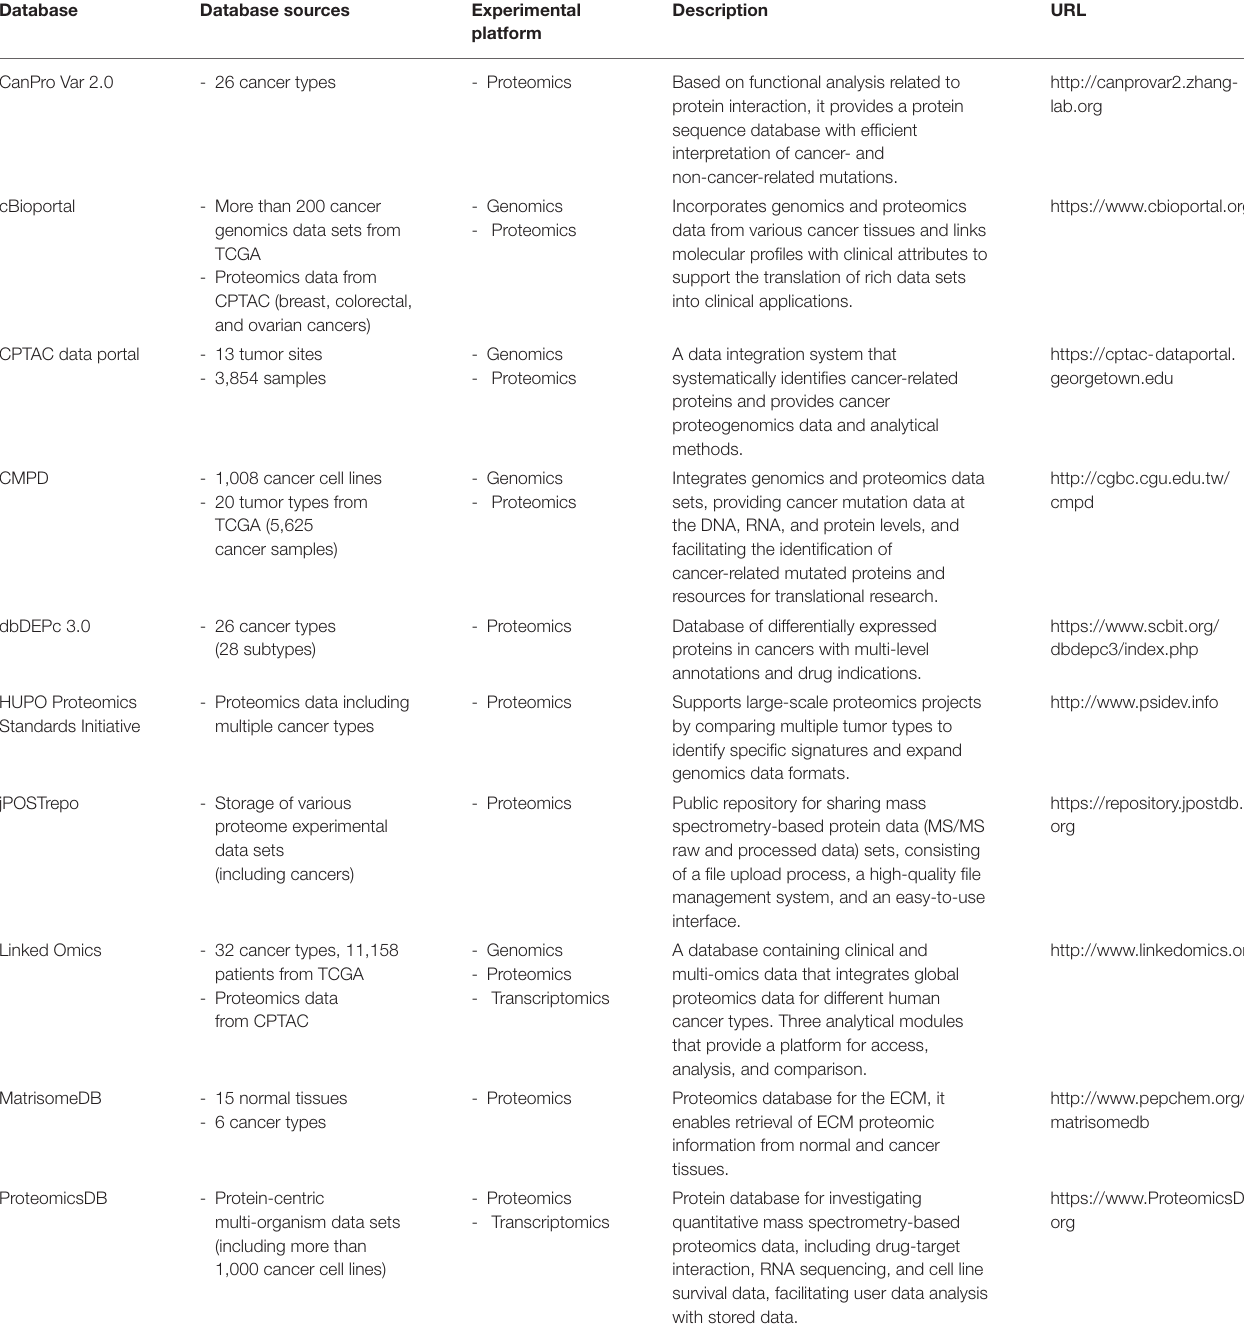
TABLE 5 | Databases containing cancer proteomics data